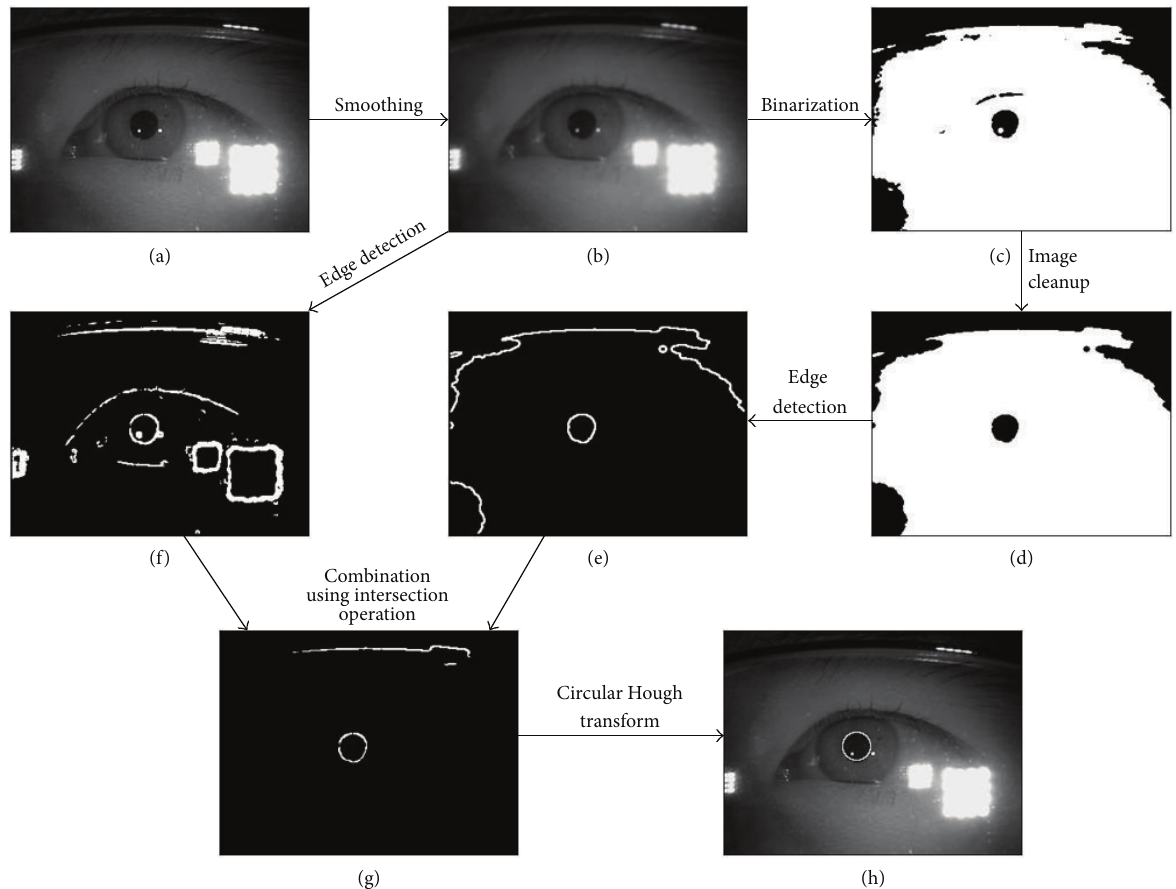
Figure 2: The proposed edge-map creation technique for pupil localization: (a) an iris image from CITHV4; (b) smoothed iris image, on applying 5 × 5 Gaussian filter with 𝜎 = 1.0 on (a); (c) binary image, after thresholding (b) with 𝑇 = 40 ; (d) cleaned binary image, obtained from (c) using hole filling and image opening for black objects; (e) edge - detected image, on applying Sobel edge detector without thinning on (d); (f) edge - detected image, on applying Sobel edge detector without thinning on (b); (g) edge-map, obtained by combining (e) and (f) using intersection operation; (h) pupil localized iris image obtained after applying CHT on